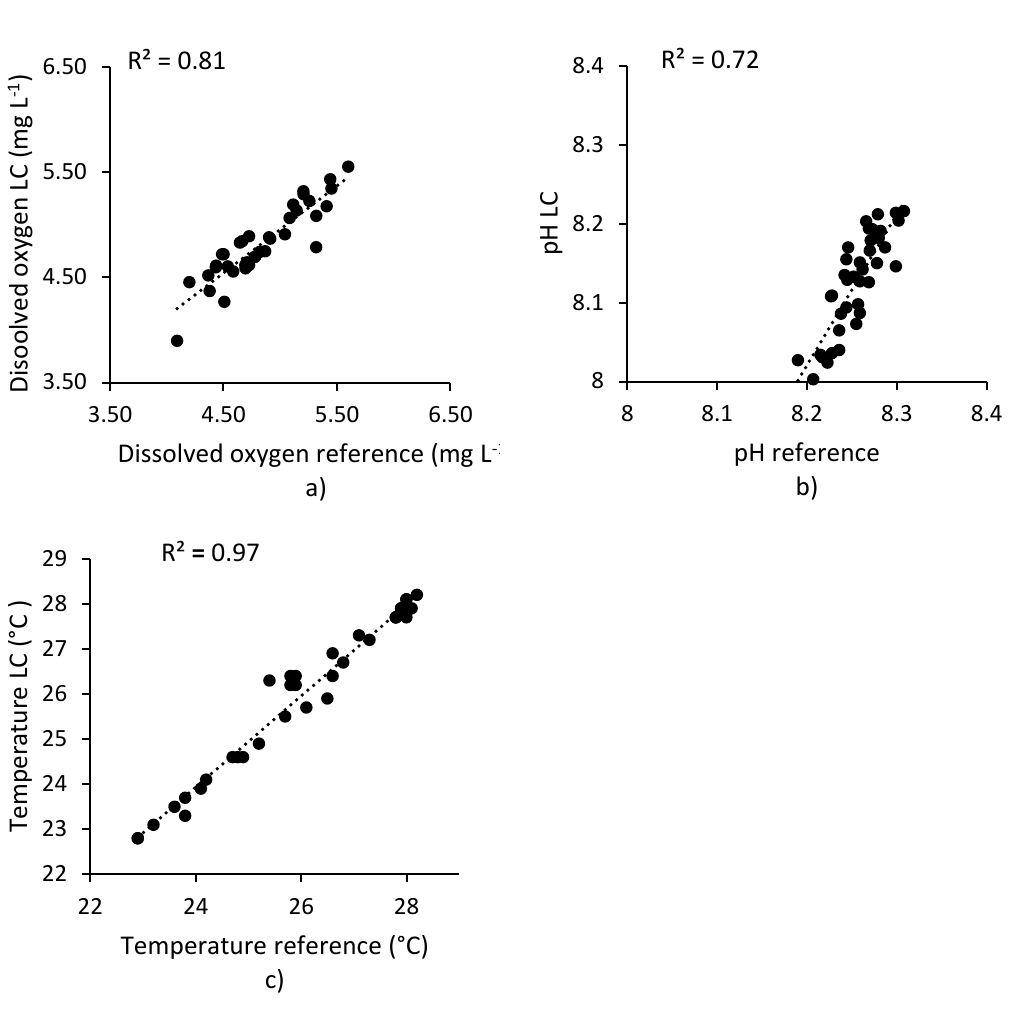
Figure 7. Scatterplots of low-cost open source hardware data versus reference equipment data. Dotted lines show the calculated r 2 value of dissolved oxygen ( a ), pH ( b ) and temperature ( c ).